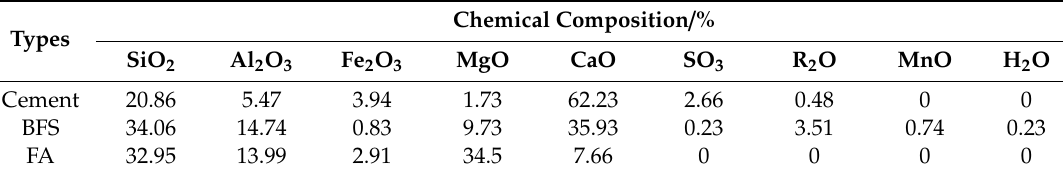
Table 2. Chemical composition of the cementitious